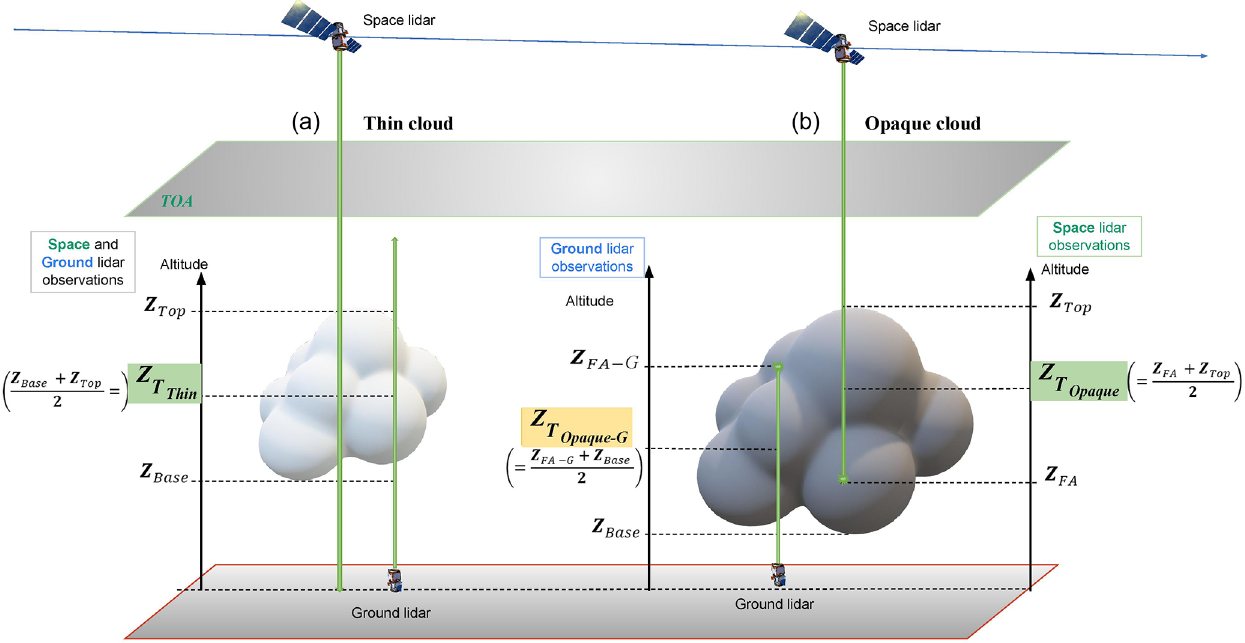
Figure 1. Schematic of cloud altitudes seen from space lidar and from a ground-based lidar in an atmospheric column containing thin cloud only (a) and opaque cloud only (b) . The altitudes used to retrieve the surface LW CRE from CALIPSO–GOCCP are reported in